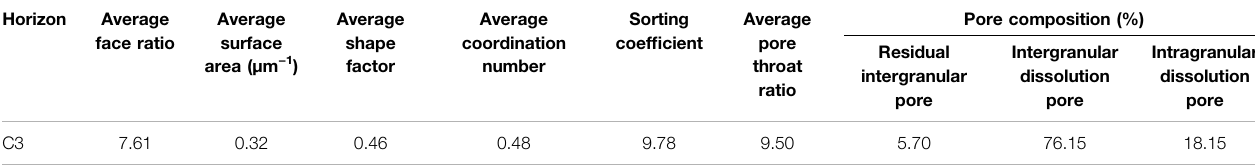
TABLE 1 | Types and characteristic parameters of pores analyzed for samples in the Chang 3 Member.